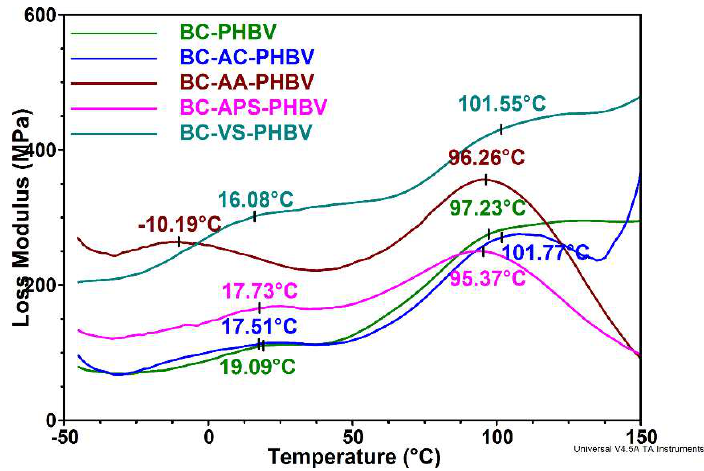
Figure 10. Loss modulus of different treated BC-PHBV nanocomposites .